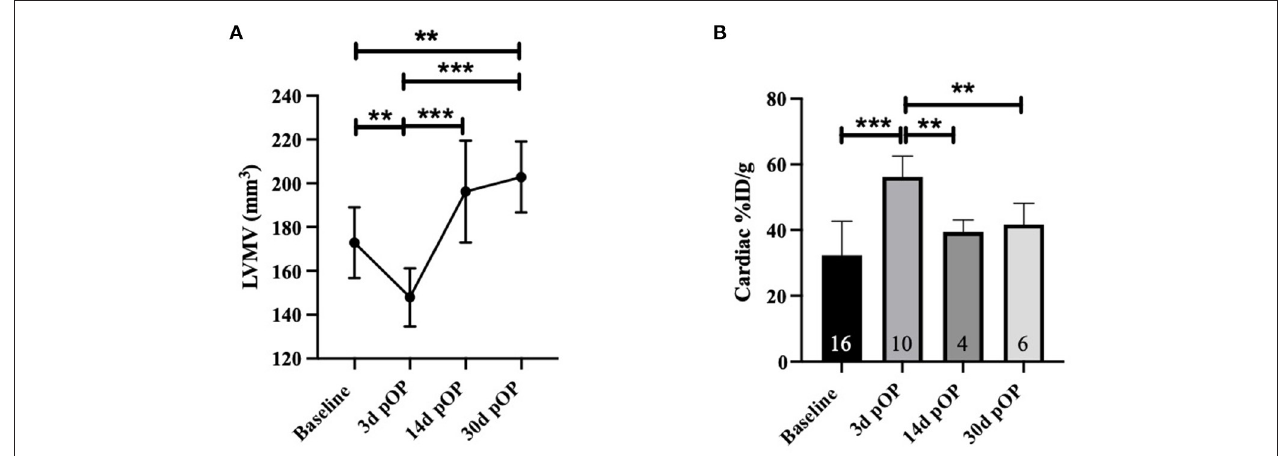
FIGURE 3 | Alterations in LVMV and cardiac %ID/g in myocardial infarction in 10 weeks old mice (A) displays the LVMV and (B) for cardiac %ID/g at baseline, 3, 14- and 30-days post-MI. All groups: n = 4-16. All data represent mean ± SD. * p = 0.05, ** p < 0.01, *** p < 0.001.